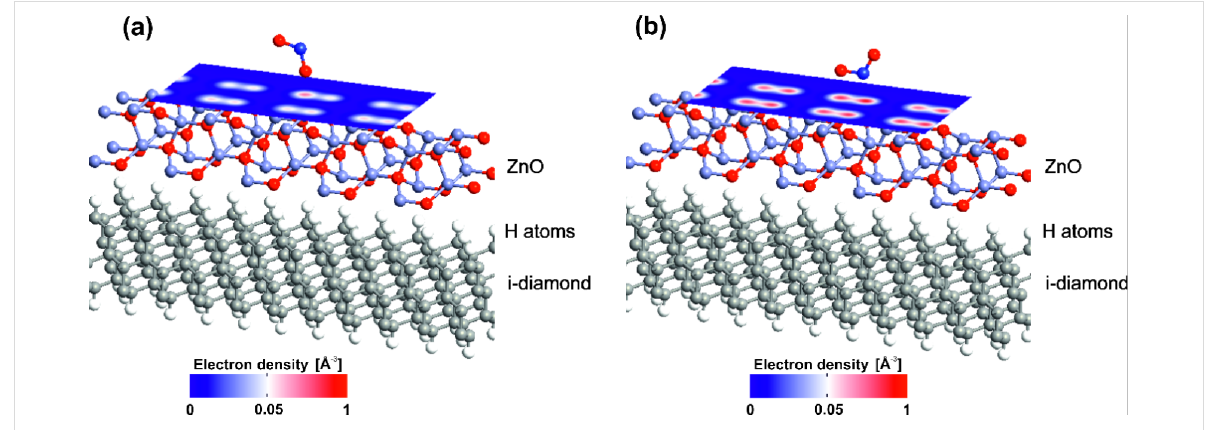
Figure 7: Electron density distribution of (a) T-shaped NO 2 and (b) L-shaped NO 2 molecules.